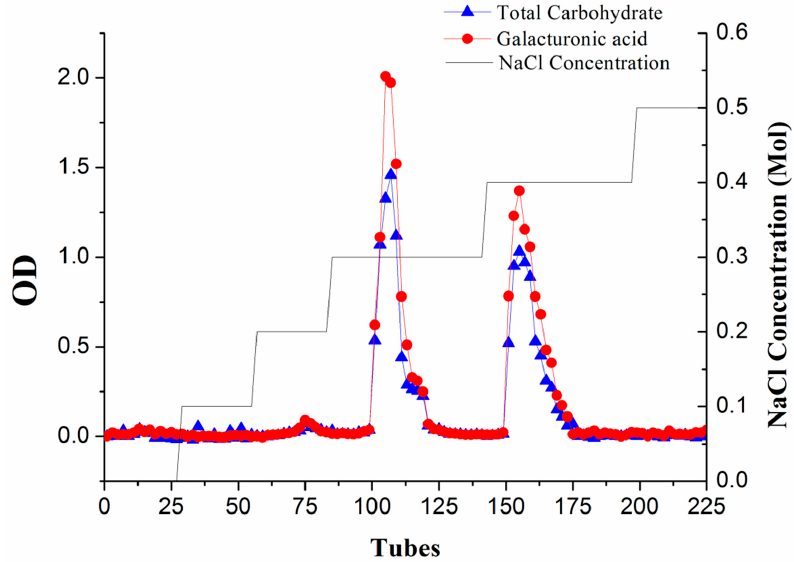
Figure 1. The profile of water-extracted pectin (WEP) on anion-exchange chromatography was eluted with distilled water and a stepwise gradient of NaCl aqueous solutions (0.1–0.5 M NaCl), detected by the phenol-sulphuric acid method at 490 nm and the m-hydroxybiphenyl method at 525 nm.